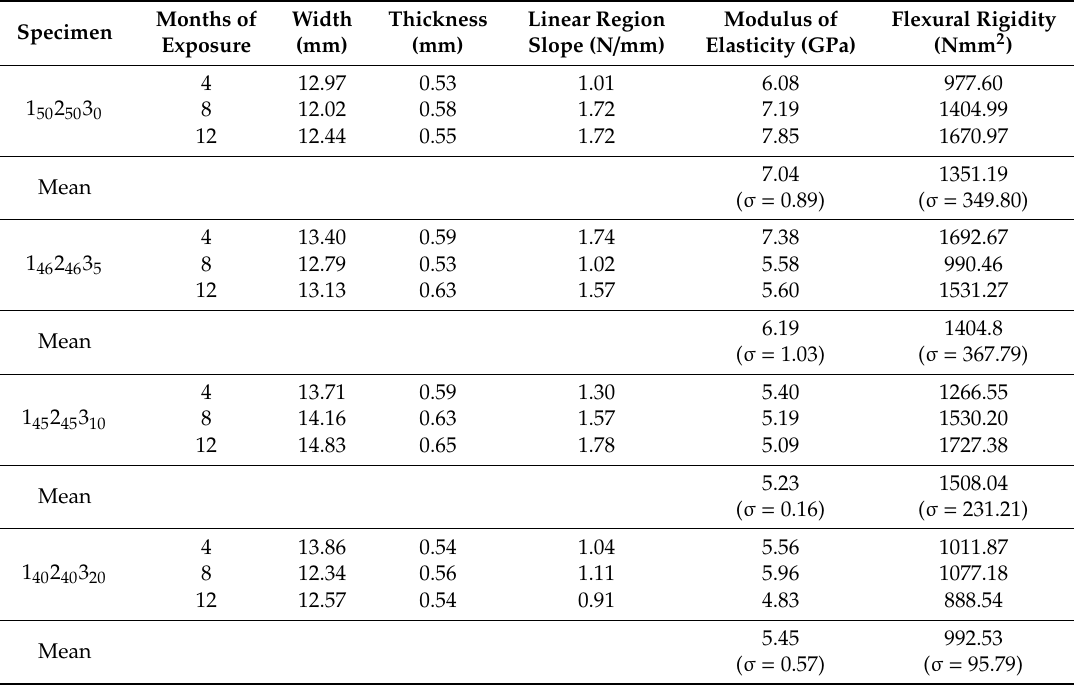
Table 7. Three-point bending data for the cured laminates as a function of POSS content after 4, 8, and 12 months of atomic oxygen